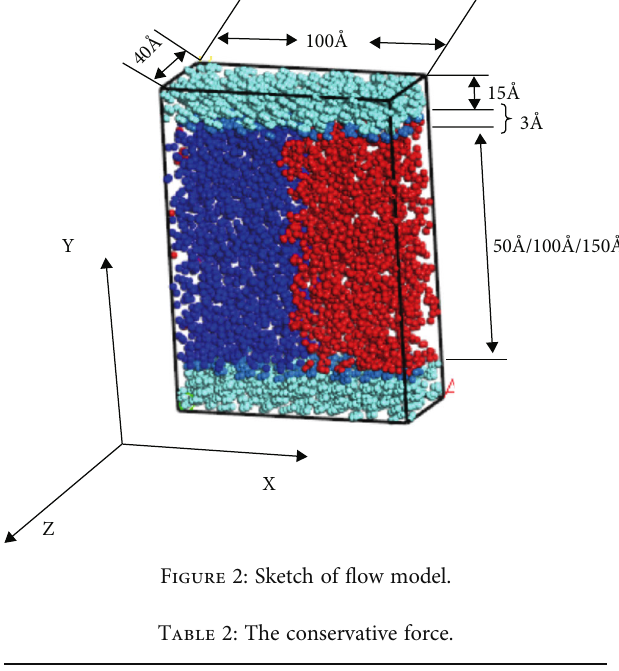
Figure 1: Work fl ow of the simulation. Table 1: Coarse grain method.